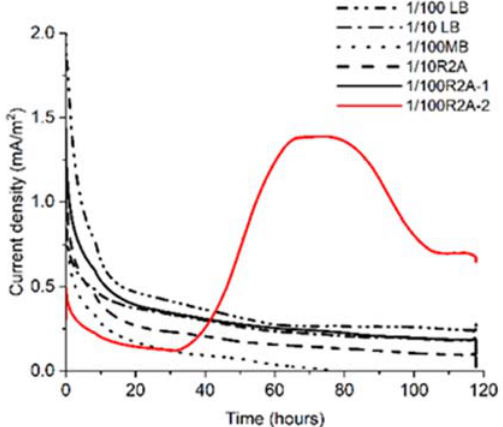
Figure 1. Comparison of current production among five different media for incubating bacteria that can pass 0.22 μ m Filter in a soil sample.